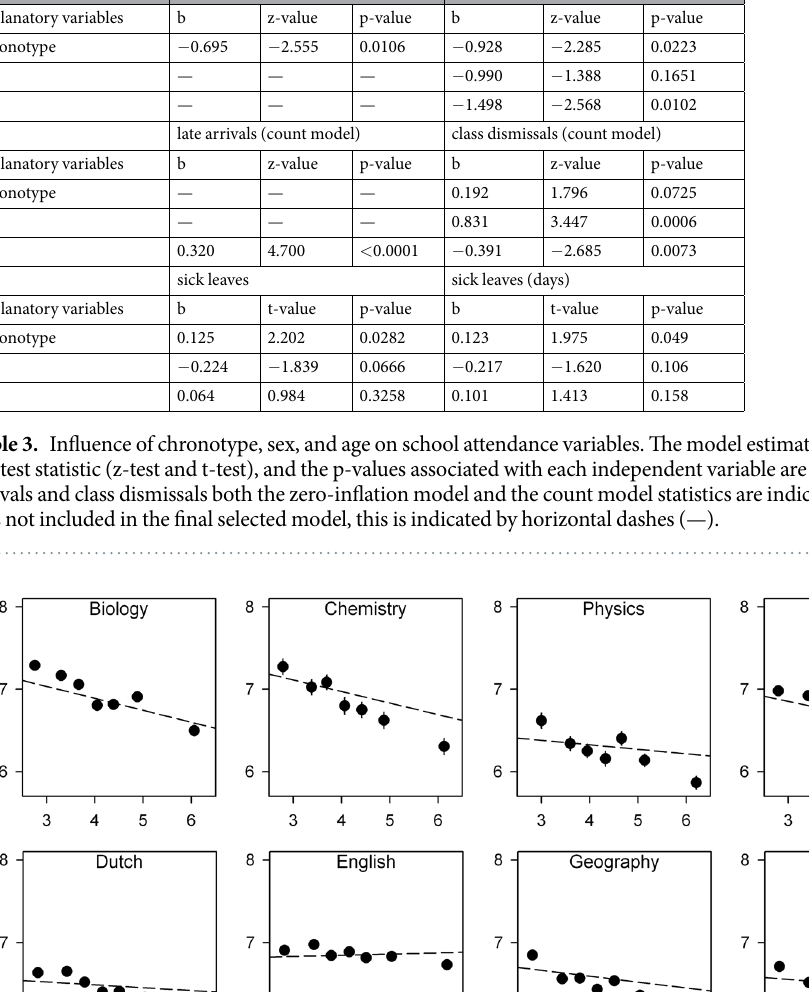
This represents a difference from the 55 th to the 43 rd percentile of grades in our data set. The model selection based on the AIC revealed that sleep duration was one of the weaker predictors among our explanatory variables. Rather chronotype, sex, and school attendance most closely correlated with school grades. Sleep duration was significantly associated with grades only without controlling for other variables such as school attendance and chronotype. In addition, our mediation analysis revealed a significant direct effect of chronotype on grades independent of sleep duration on school days. Comparison between the direct and the indirect (sleep-duration mediated) effect of chronotype showed that the strength of the effect of the former was